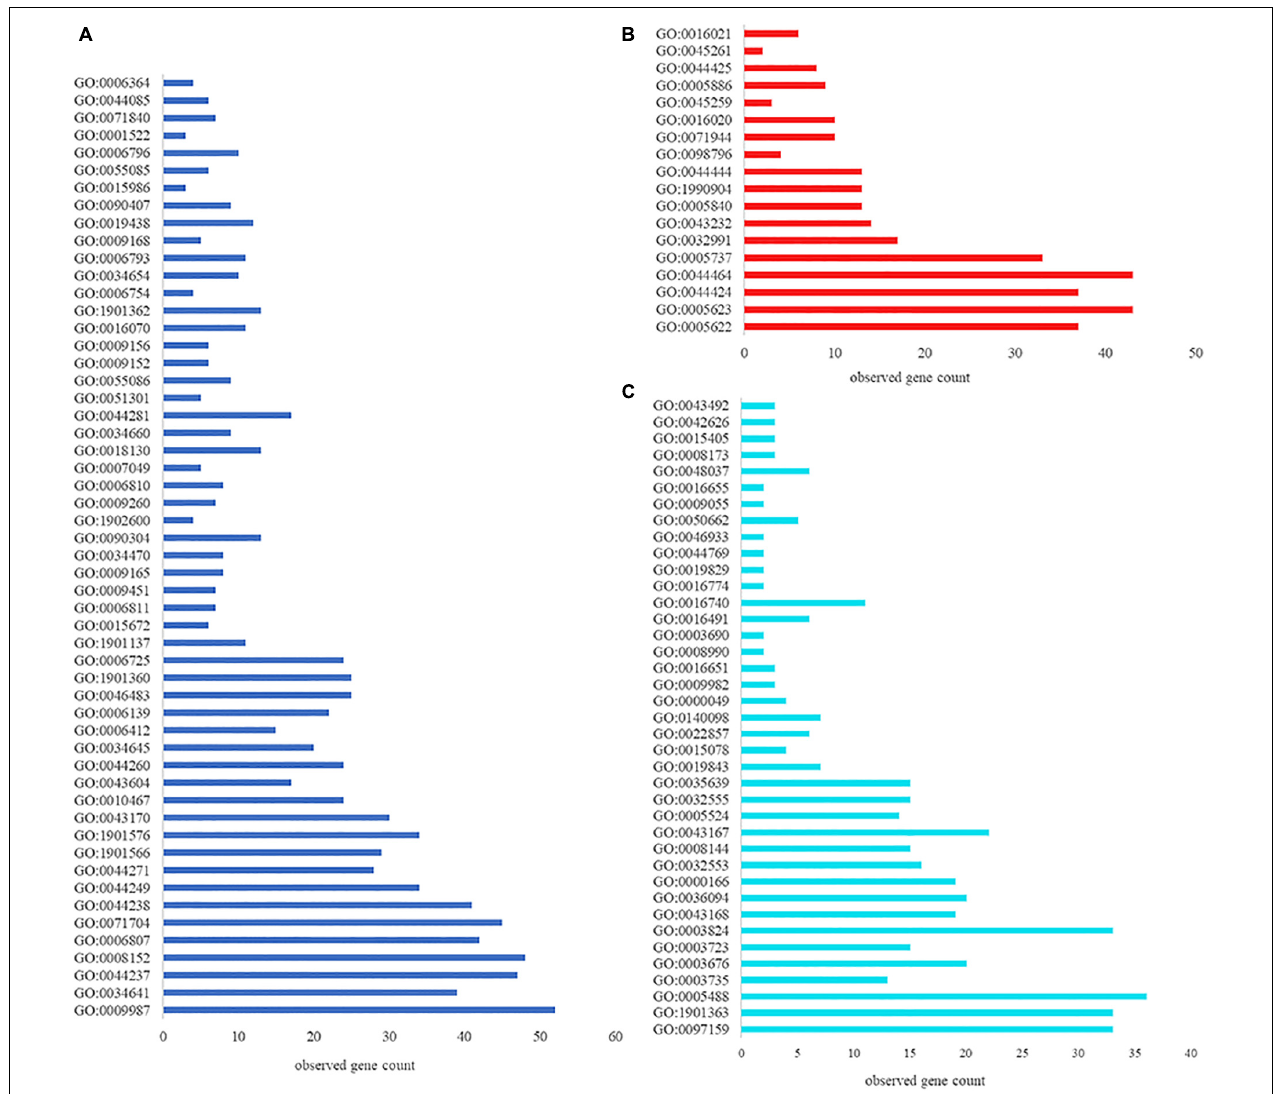
FIGURE 6 | GO function annotation and enrichment analysis. (A) Biological process; (B) Cellular component; (C) Molecular